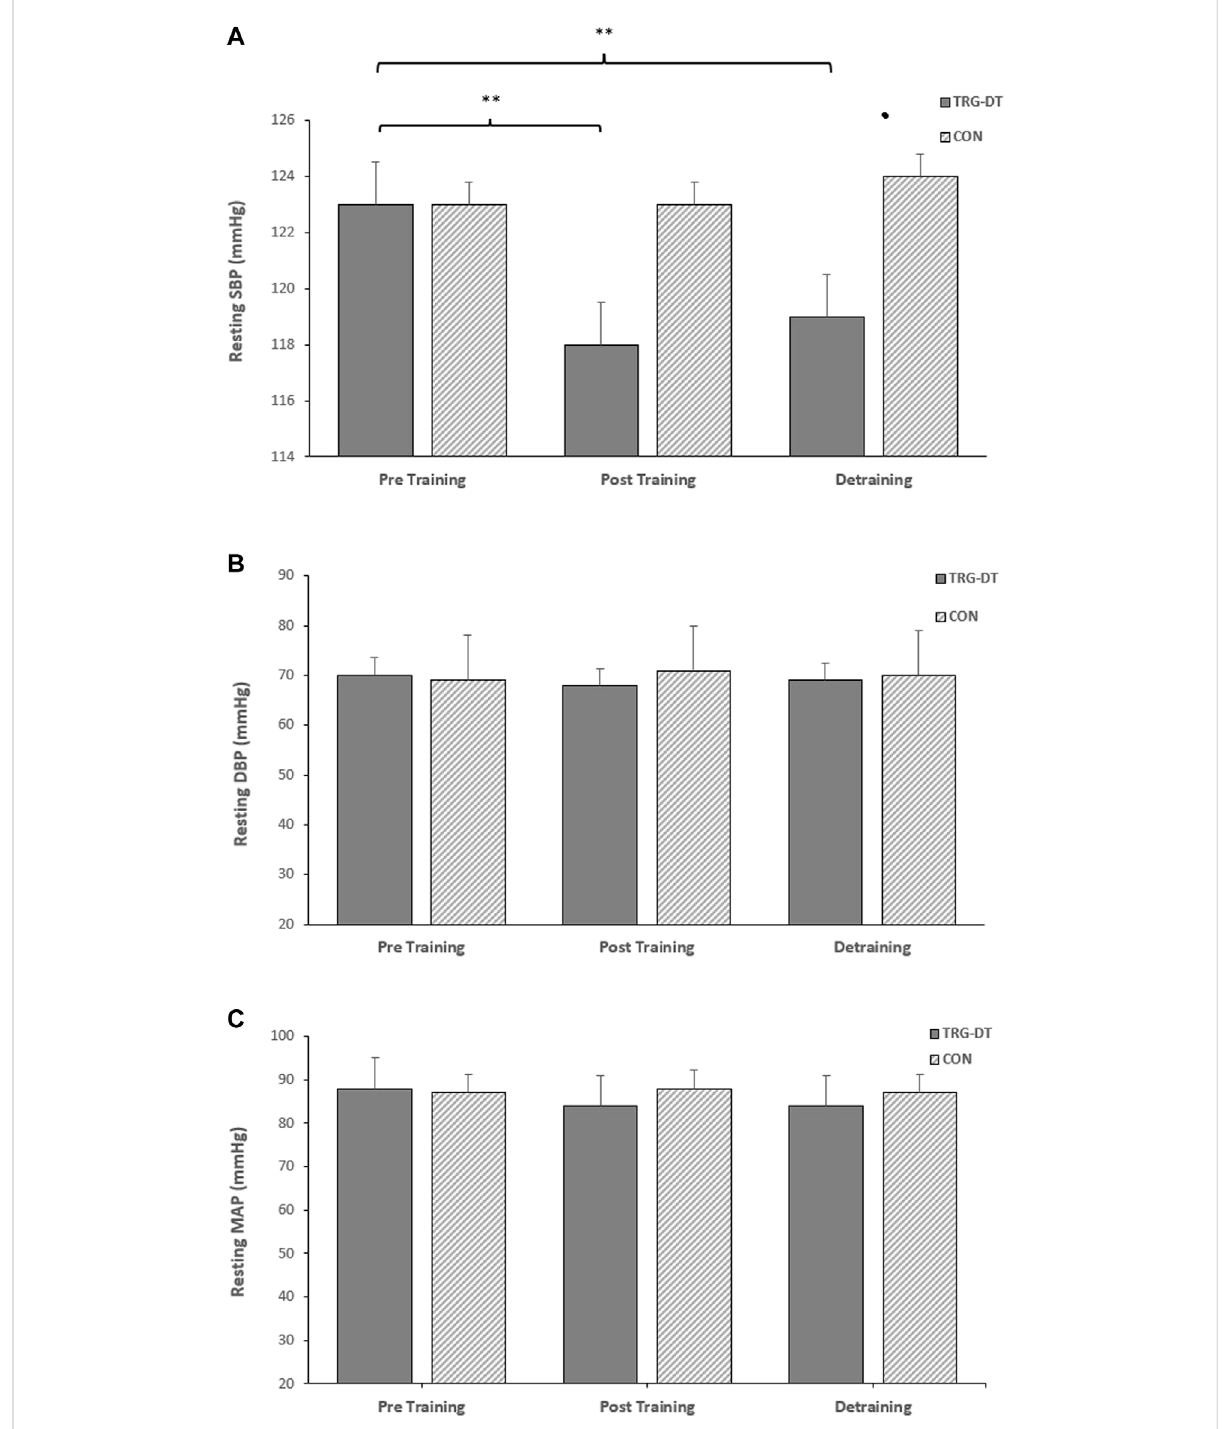
FIGURE 2 Effectsof8 weeksofisometricresistancetraining(IRT)followedby8 weeksofdetrainingon (A) ,restingsystolicbloodpressure(SBP) (B) ,resting diastolic bloodpressure (DBP)and (C) ,resting meanarterialpressure (MAP)for isometrictraining-detraining (TRG-DT)andcontrol(CON) groups. * p value < 0.005, ** p value <